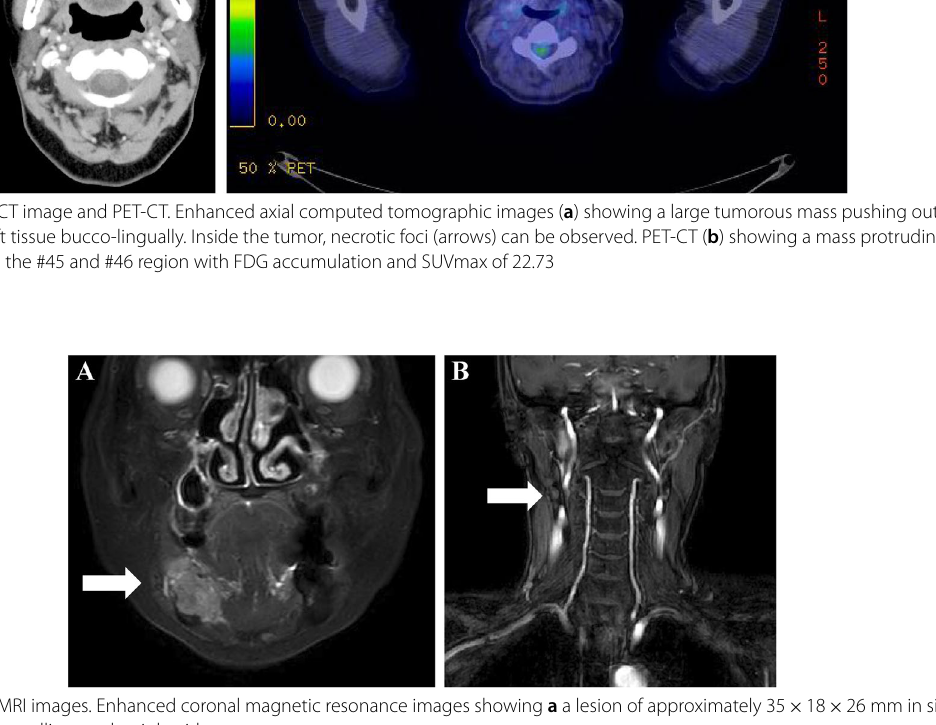
18 26 mm in size and b × ×